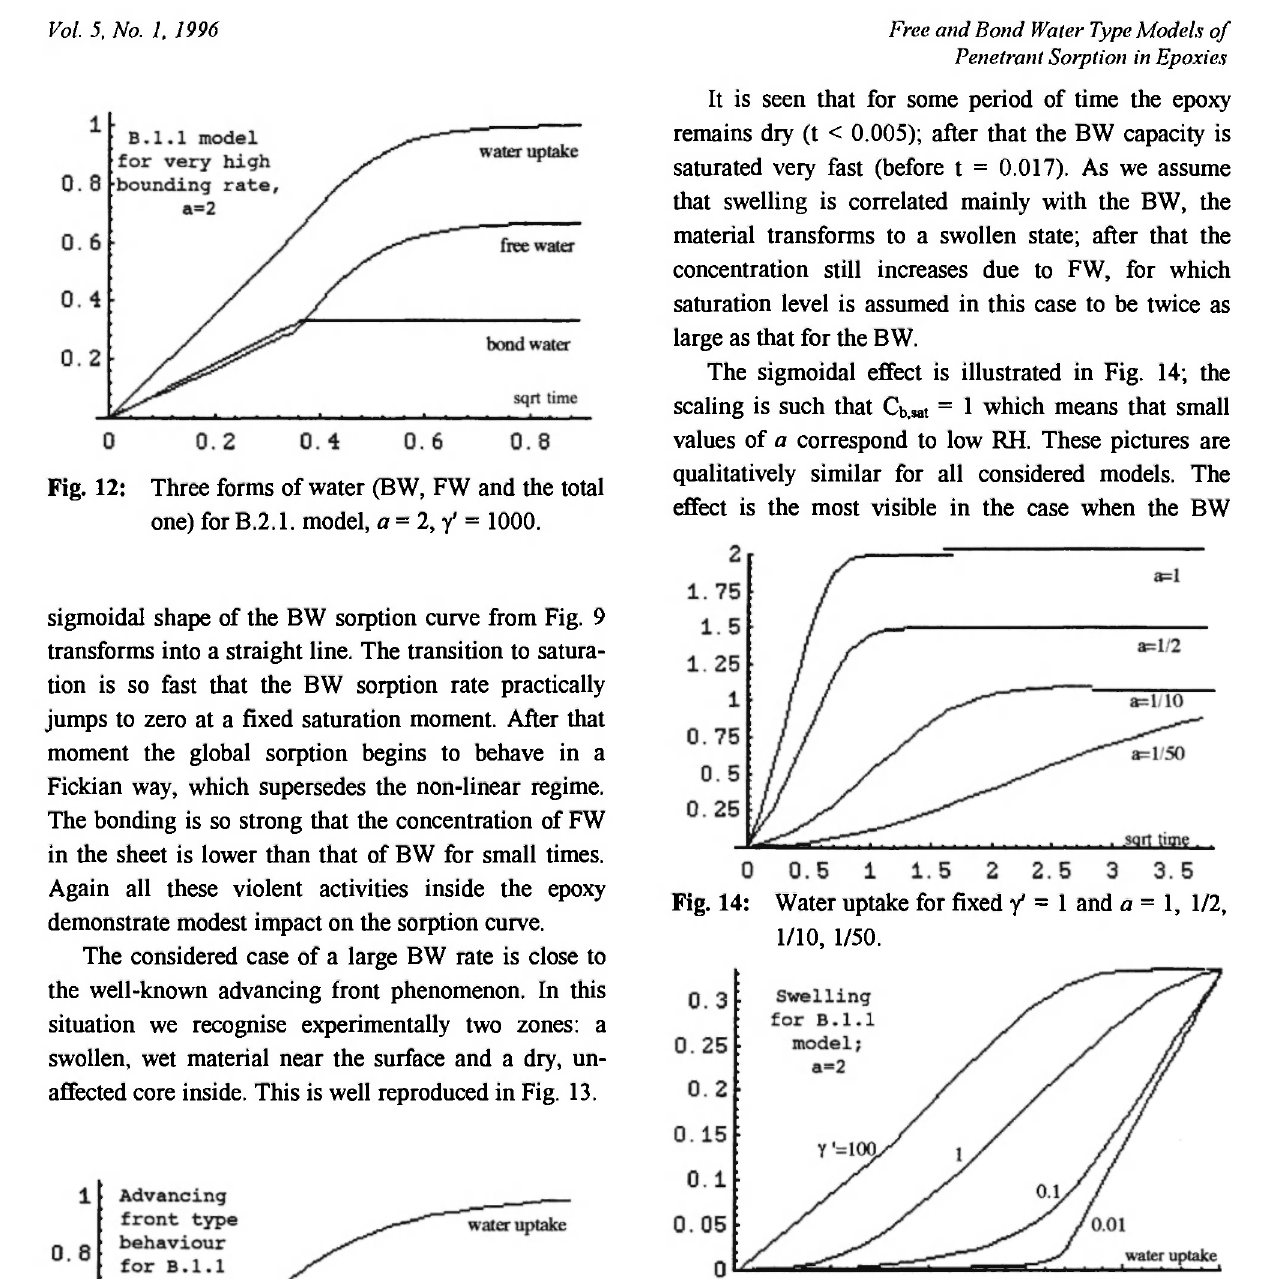
Fig. 15: Swelling for the same values of the governing parameters as in Fig.